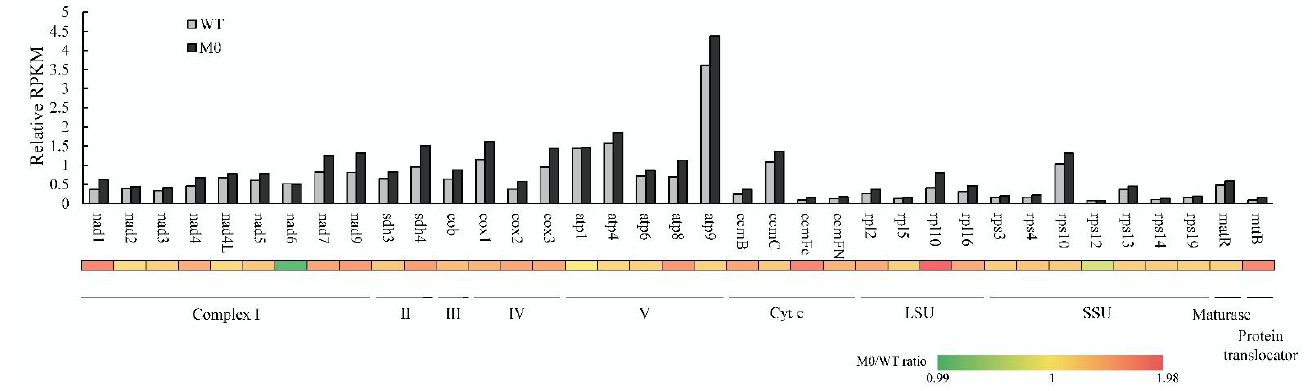
Figure 3. The relative expression levels of mitochondrial protein-coding genes in PEP-deficient tobacco and wild-type plants. The relative RPKM analysis was used to measure the relative level of mitochondrial protein-coding transcripts by mapping the RNA-Seq reads from the leaf tissues of the PEP-deficient (M0) tobacco and wild-type (WT) plants to the mtDNA (NC_006581) template using the CLC Genomic Workbench 10 with the parameters of L=0.8 and S=0.8. The RPKM of the nuclear EF-1 α transcripts was used as a control for normalization, set to 1. The ratio of relative RPKM between M0 and the WT is illustrated as a heatmap at the bottom. Complex I, II, III, IV and V, respiratory electron transport chain complex I, II, III, IV and V (ATP synthase complex); Cyt c, cytochrome C biogenesis; LSU, ribosomal large subunits; SSU, ribosomal small subunits.